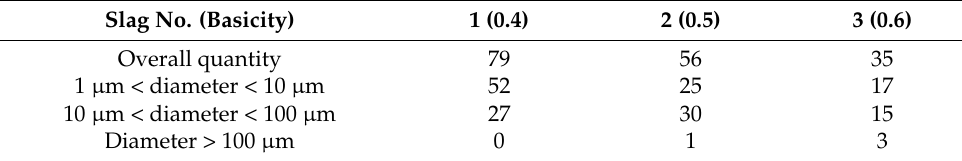
Figure 2. Feature of quenched slag near the silicon-slag interface (backscattered electron image, No. 1 slag with a refining time of 5 min).